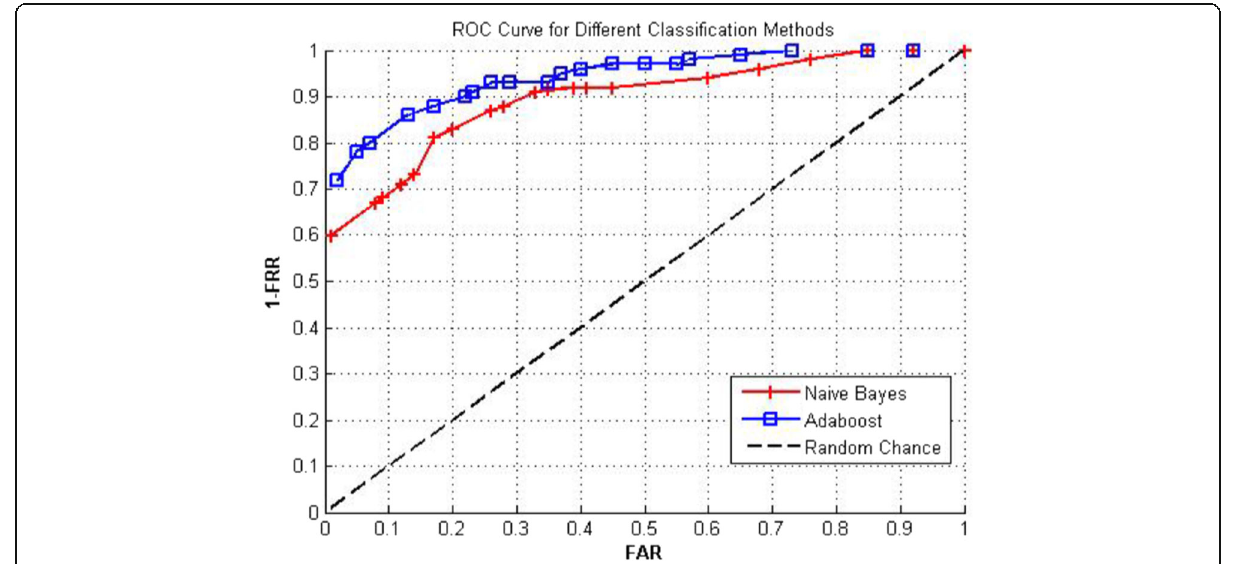
Fig. 6 Comparison of Naïve Bayes and AdaBoost methods